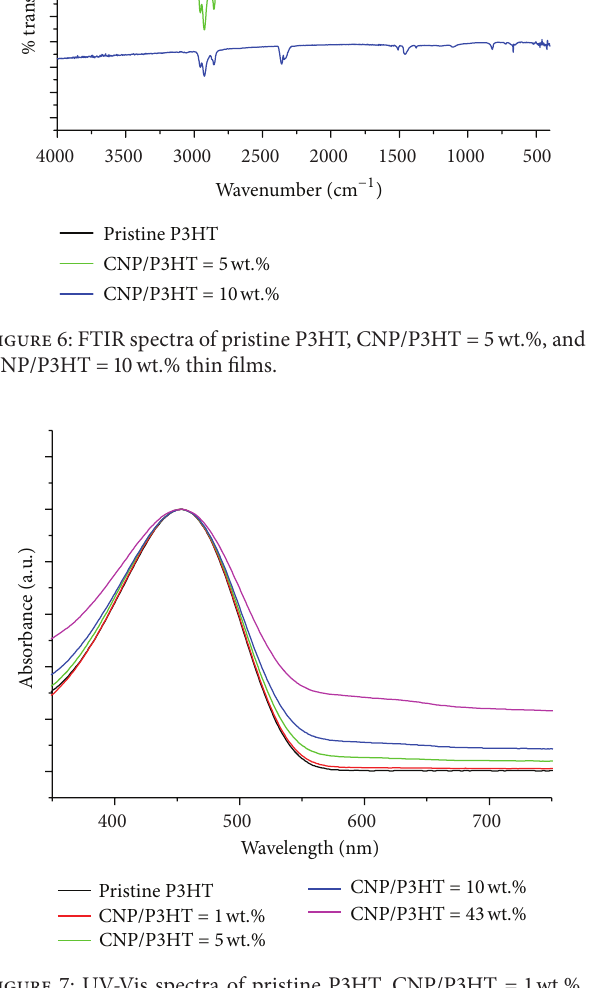
Figure 7: UV-Vis spectra of pristine P3HT, CNP/P3HT = 1wt.%, 5 wt.%, 10wt.%, and 43